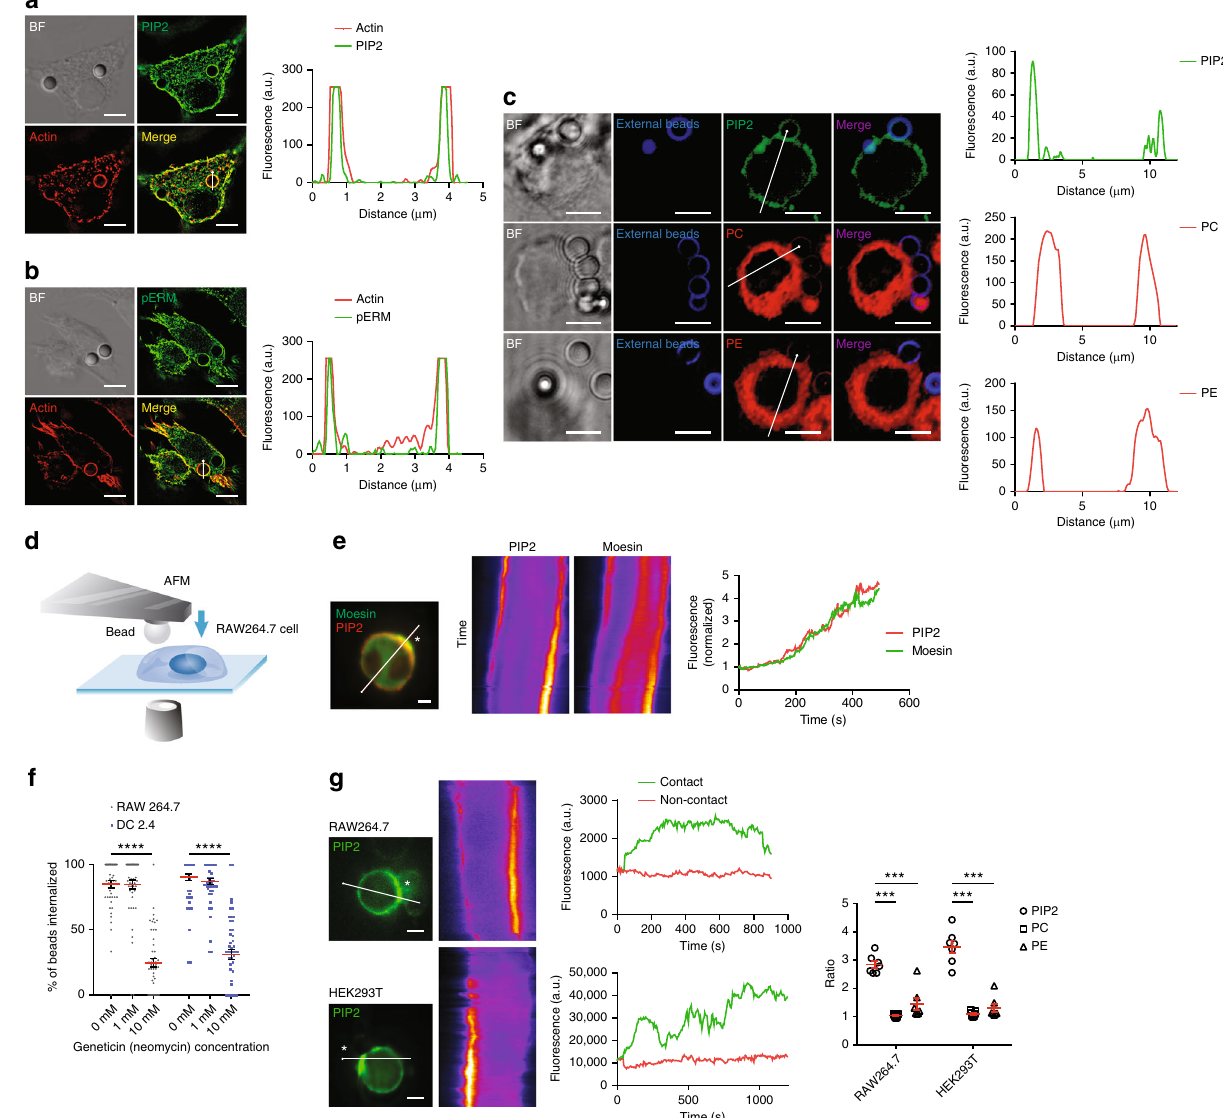
Fig. 3 Moesin signaling is downstream of PIP2 sorting driven by solid structures. a PIP2 (green) was visualized with PH-PLC δ -GFP alongside actin cytoskeleton by SIM on RAW264.7 cells incubated with 3 μ m naked polystyrene beads. Line pro fi les corresponding to fl uorescence intensities of PIP2 and actin were generated across the indicated phagocytic cups. N = 5. Scale bars, 5 µ m. b Identical to a except that pERM (T558) and actin were analyzed. Phospho-ERM were visualized with anti-pERM antibody. N = 4. Scale bars, 5 µ m. c PIP2 (green), PC (red), and PE (red) were visualized with PH-PLC δ -GFP, TopFluor TMR-PC or TopFluor TMR-PE on RAW264.7 cells incubated with 3 μ m biotin-BSA-coated polystyrene beads as in a . N = 3. Scale bars, 5 µ m. d Schematic of fl uorescence imaging of bead/cell contact by a bead delivered with AFM. e PH-PLC δ -mCherry and Moesin-EGFP were co-expressed in RAW264.7 cells. A polystyrene bead was used to contact the cell surface. Images were taken at a 6 s interval for 500 s. Localization of PIP2 and Moesin at the site of contact (indicated with “ * ” ) was examined with kymographs generated from the indicated line. The normalized fl uorescence is de fi ned as the ratio of the fl uorescence intensity of PIP2 or Moesin at the site of contact over non-contact regions on the cell membrane (right). N = 3. Scale bar, 5 μ m. f Phagocytosis ef fi ciency was examined for both RAW264.7 and DC2.4 cells in the presence of 0.1 and 10 mM Geneticin. n = 50, N = 4. **** p < 0.0001 by one-way ANOVA with Scheffé post hoc. g PH-PLC δ -GFP-expressing RAW264.7 or HEK293T cells were touched with a single polystyrene bead recorded with a 6 s interval for 900 and 1200 s, respectively. Polarized distribution of PIP2 upon touching at the site of contact (indicated with “ * ” ) on cell membrane was examined with kymograph. The normalized fl uorescence of PIP2, PC, and PE was calculated for RAW264.7 and HEK293T cells (right). n ≥ 10, N = 3. Scale bars, 5 µ m. *** p < 0.001 by one-way ANOVA with Scheffé post